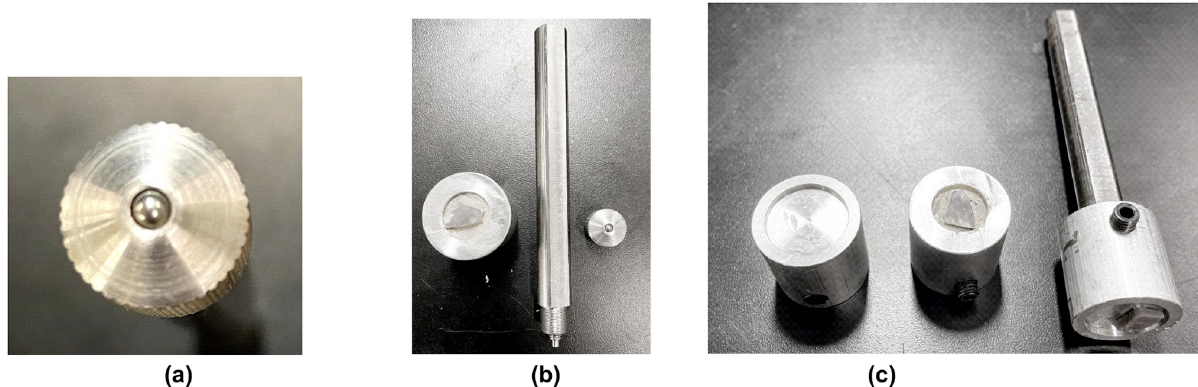
Fig 2. Pin holder types. (a) Conventional Steel ball used in pin-on-disk type of Tribology Experiment, (b) Customized Sample holder setup (on left) conventional sample holder (on right), (c) Customized sample holder, Customized sample holder with Flint sample & the stone sample on the sample holder rod (from left to right).